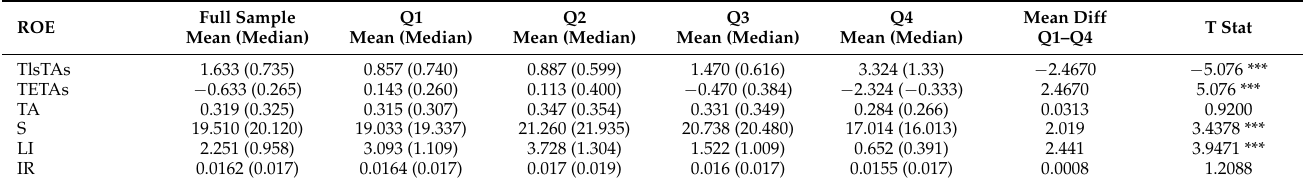
Table 5. Results of TLsTAs, TETAs, TA, S, LI, and IR by the Quartiles of